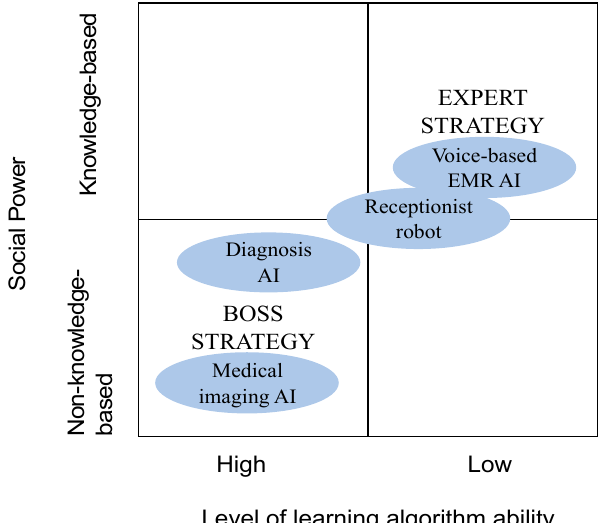
Figure 4. Understanding AI adoption and power strategy.